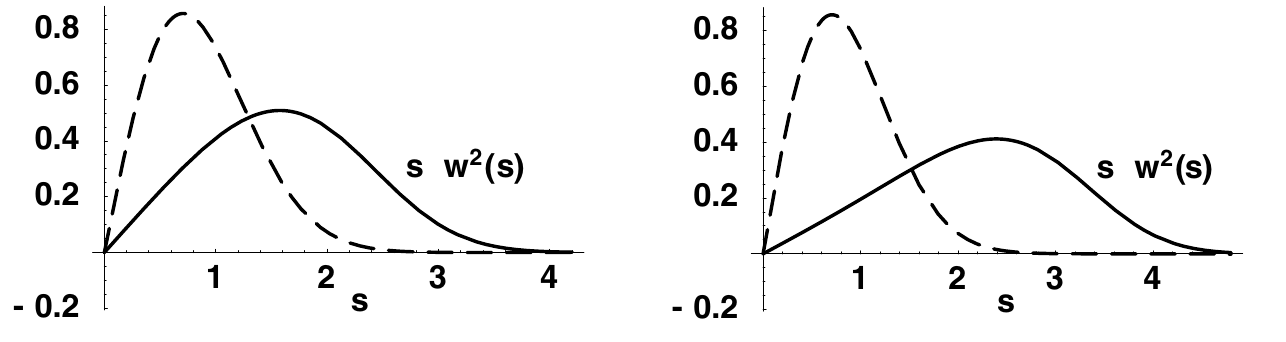
FIG. 4. The radial distribution sw 2 (cid:2) s (cid:3) compared with the distribution in absence of space charge (dashed line). The space-charge strength is (cid:7) (cid:21) 22 : 5 . All quantities are